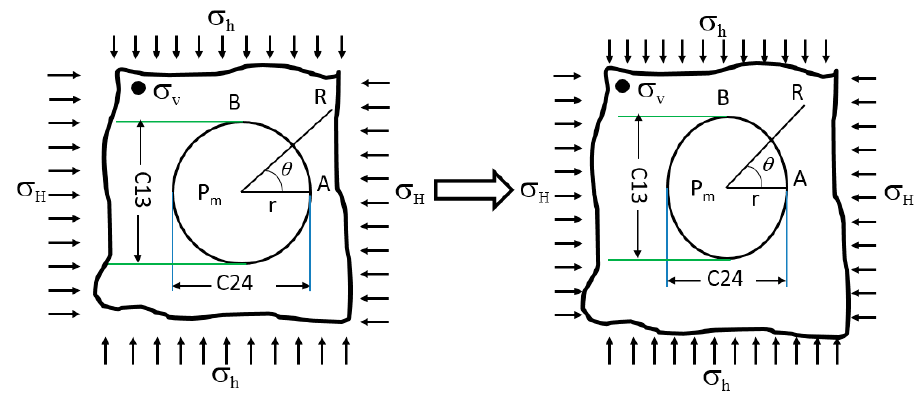
Figure 1. Schematics of borehole deformation.